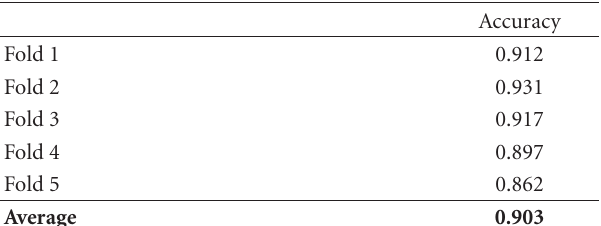
Table 4: Accuracy results of the first evaluation, EV1, where each sense has to have at least two instances tagged with it.